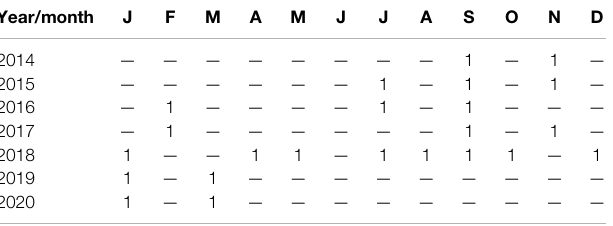
Frontiers in Earth Science |